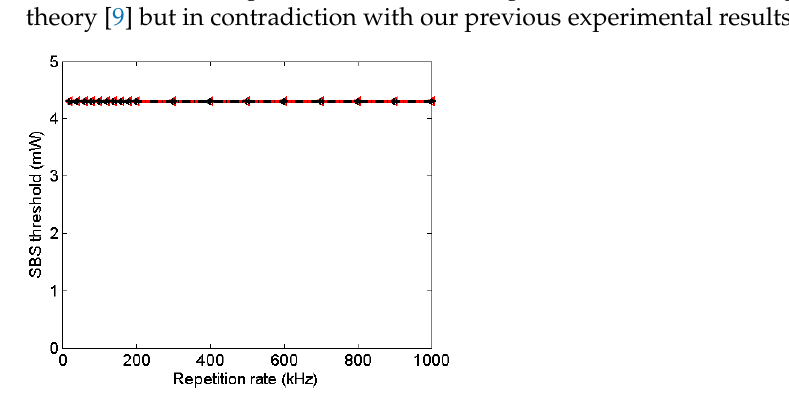
Figure 4. The simulation result of the SBS threshold with different repetition rates.